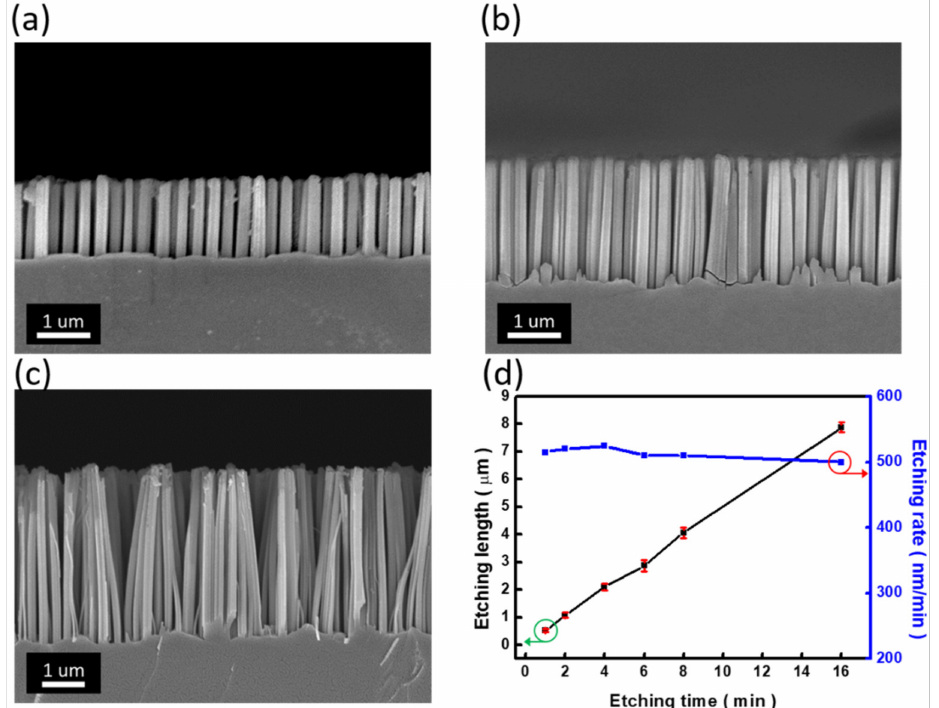
Figure 3. Cross-sectional SEM images of SiNW arrays formed on PS-patterned Si substrates after undergoing MaCE process for ( a ) 2 min, ( b ) 4 min, and ( c ) 8 min. ( d ) Relationship between etching time and etching length ( left )/average etching rate ( right